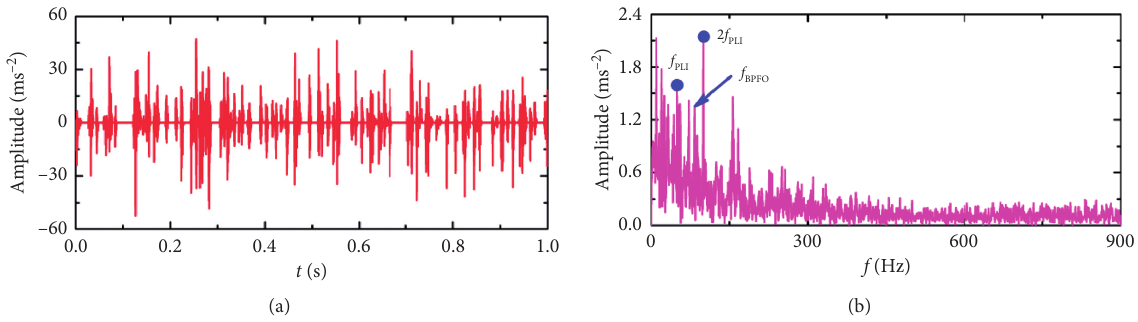
Figure 14: Results obtained by SBAKW: (a) extracted signal and (b) Hilbert envelope spectrum of signal in